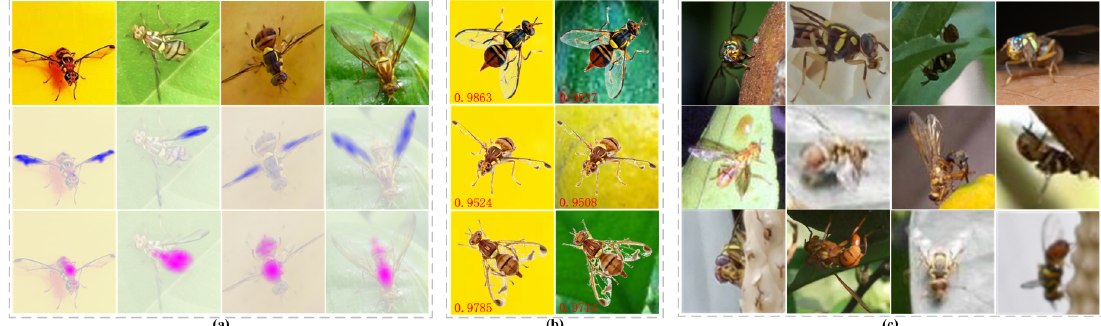
Figure 8. Analysis of the recognition of some samples. ( a ) Visualization of the attention modules. The blue and magenta areas visualize the M 1 and M 2 modules, respectively. ( b ) Comparison of classification scores of sample pairs with different backgrounds. ( c ) Incorrectly recognized samples in the cases of occlusion, special poses, and low image qualities.